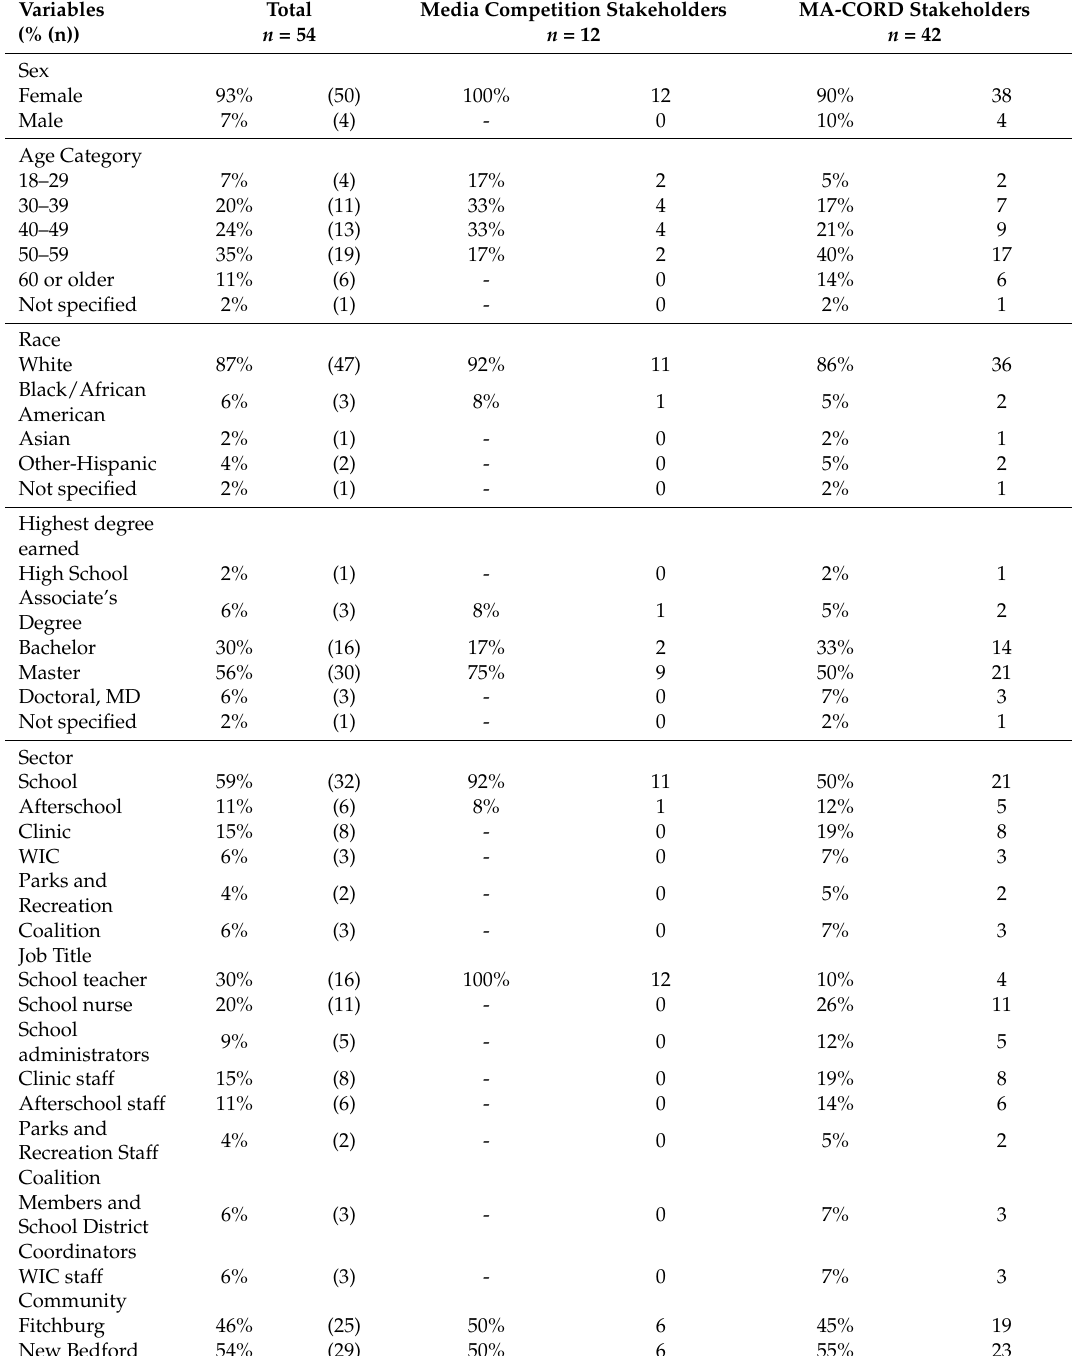
Table 2. Media Competition Interview Participation Demographic